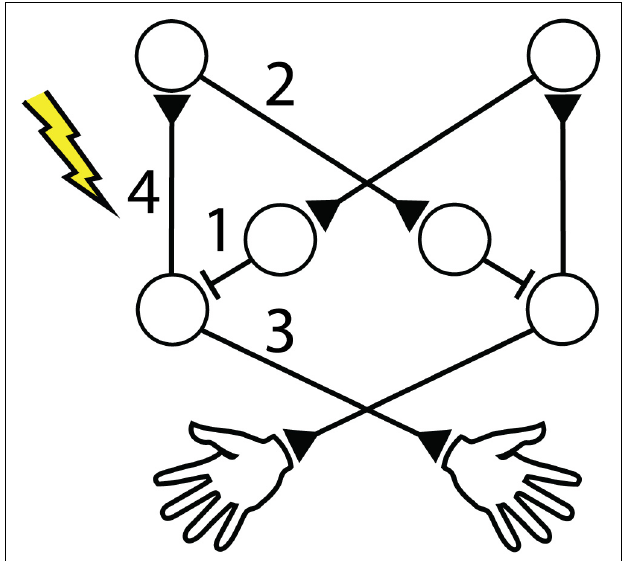
FIGURE 13 | Cortical circuitry affected by stimulation. Intra- and interhemispheric circuitry involved in unilateral movement. Numbers identify proposed affected connections with left hemispheric stimulation for (1) decrease in tRT during Contralateral CS prep , (2) decrease in tRT during Ipsilateral CS prep , (3) increase in tRT after Contralateral CS relax , and (4) decrease in ntRT after Contralateral CS relax